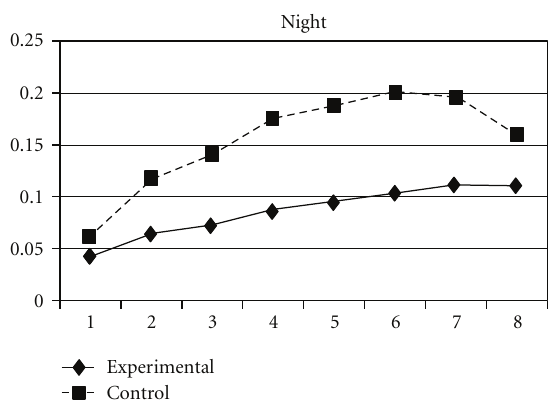
Figure 4: Growth trajectories of the experimental group (all partic- ipants) and control group using the item score of stay outside home over night as the outcome indicator.